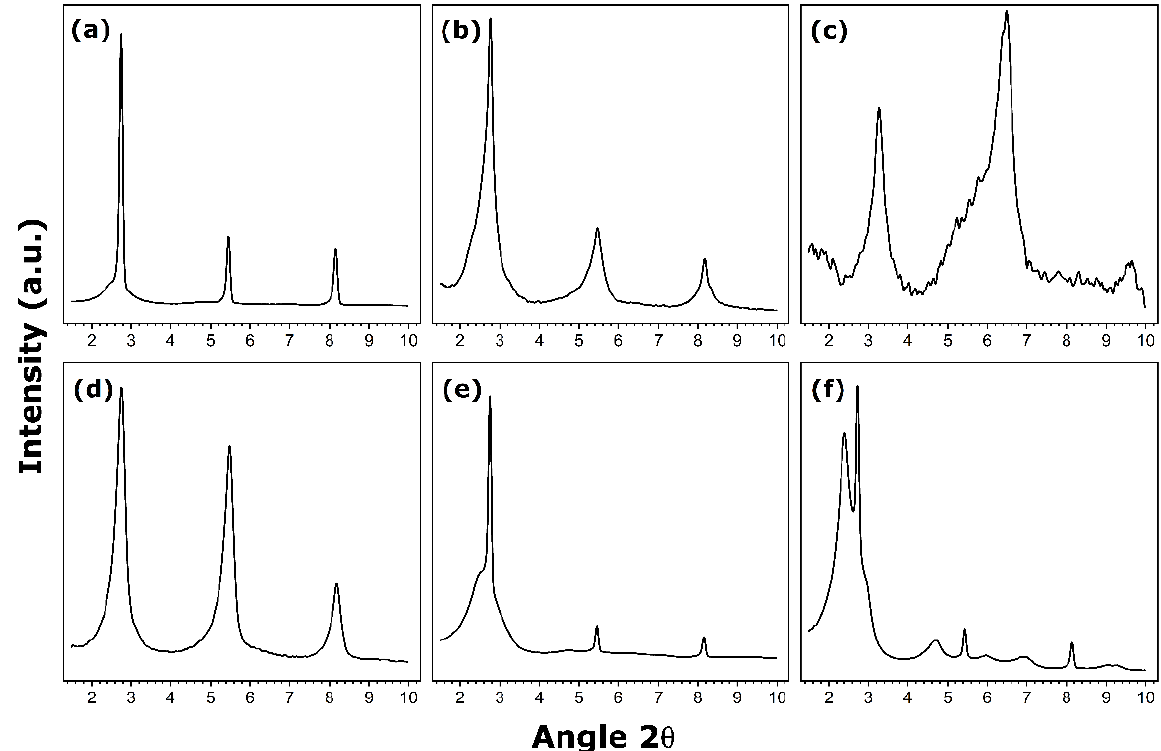
Figure 2. Small-angle XRD patterns of hybrid hexadecylamine-vanadium oxide materials prepared under the synthesis conditions detailed in Table 2 (each letter indicating a given panel corresponds to that in Table 2).